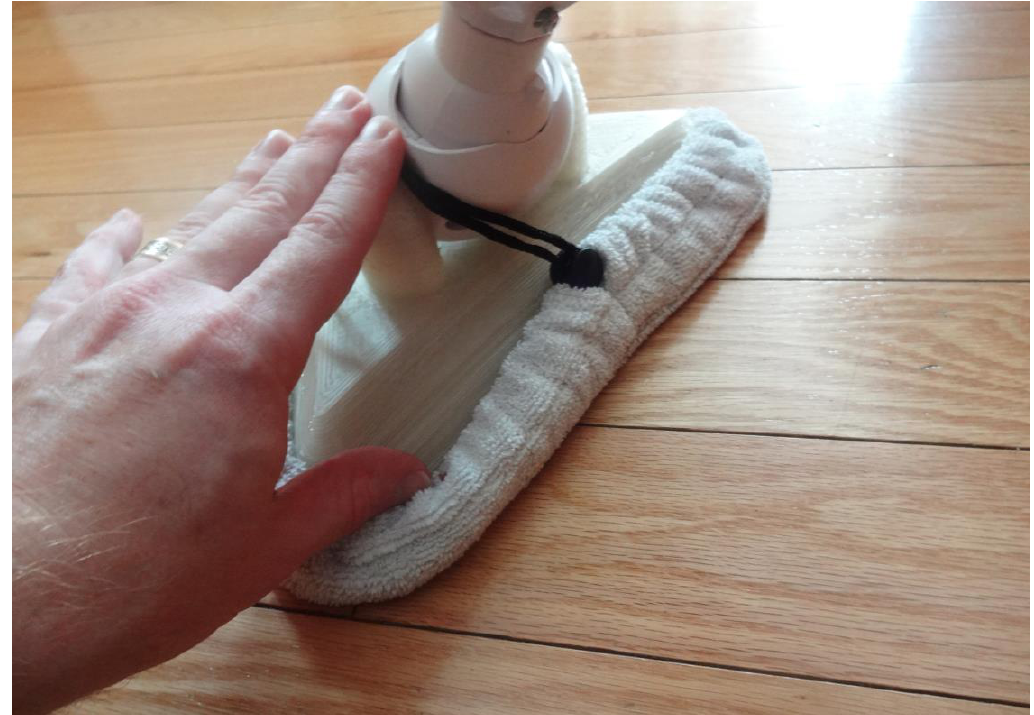
Figure 9. Waste PC 3D-printed steamer head shown assembled on steamer.